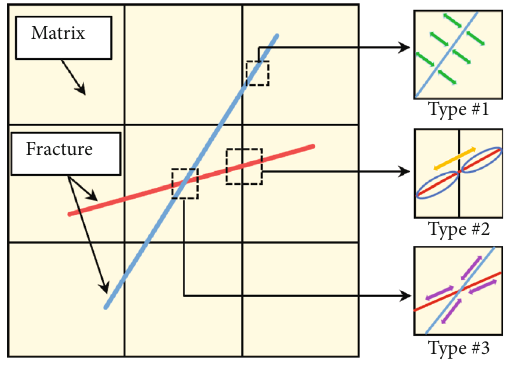
Figure 2: Schematic of the three types of NNC.